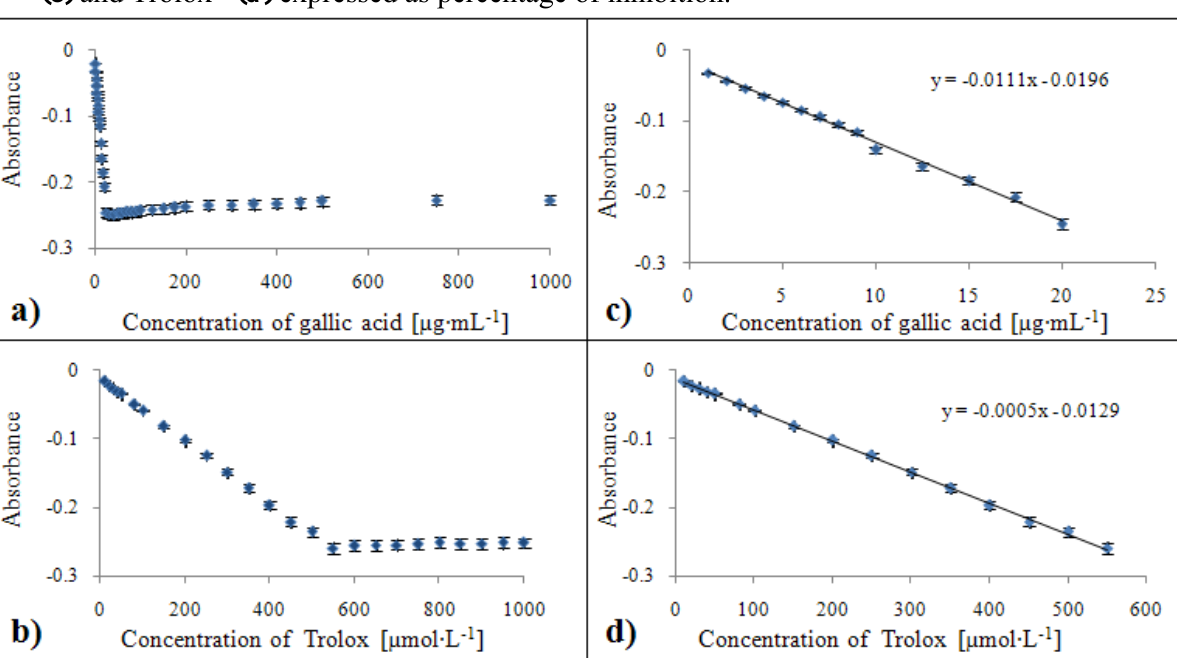
Figure 8. Dependence of absorbance of colour product on concentration of gallic acid (a) and Trolox ® (b) . Calibration curves for ABTS method related to equivalent of gallic acid (c) and Trolox ® (d) expressed as percentage of